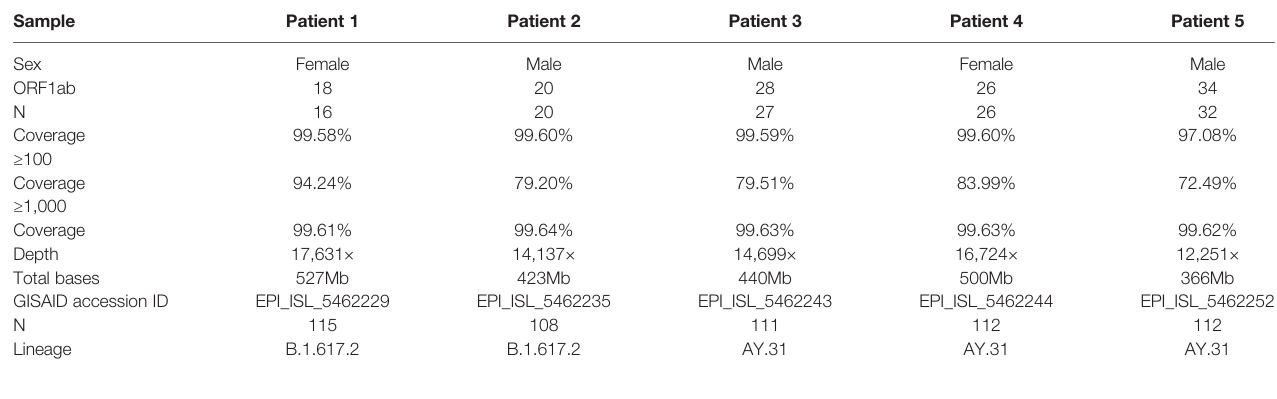
TABLE 1 | Patient information and routine RT-qPCR